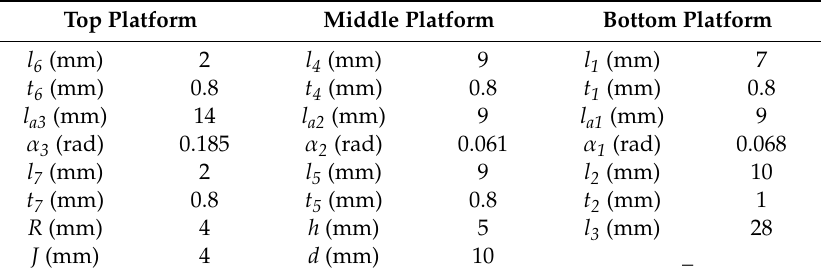
Table 1. The parameter values of the micro-positioner. Top Platform Middle Platform Bottom